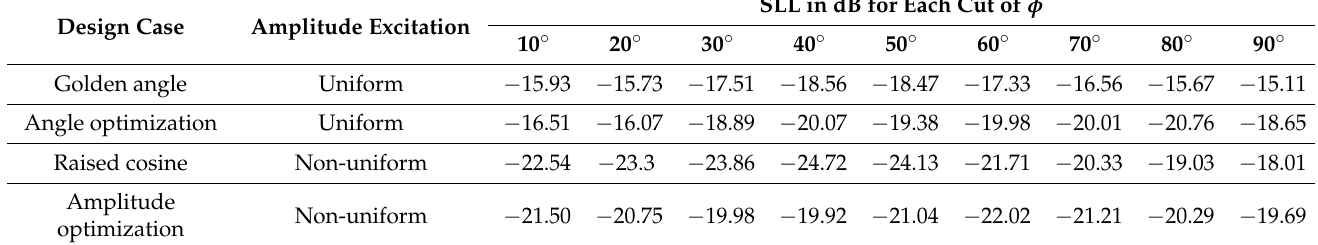
Figure 11. Radiation pattern obtained by full-wave simulation for the cases of using non-uniform amplitude excitation, as follows: ( a ) raised cosine and ( b ) optimization of amplitude excitations. Table 3. Numerical results obtained by the electromagnetic simulation for each cut of φ and the SLL performance of each proposed design case of the Fermat spiral array.